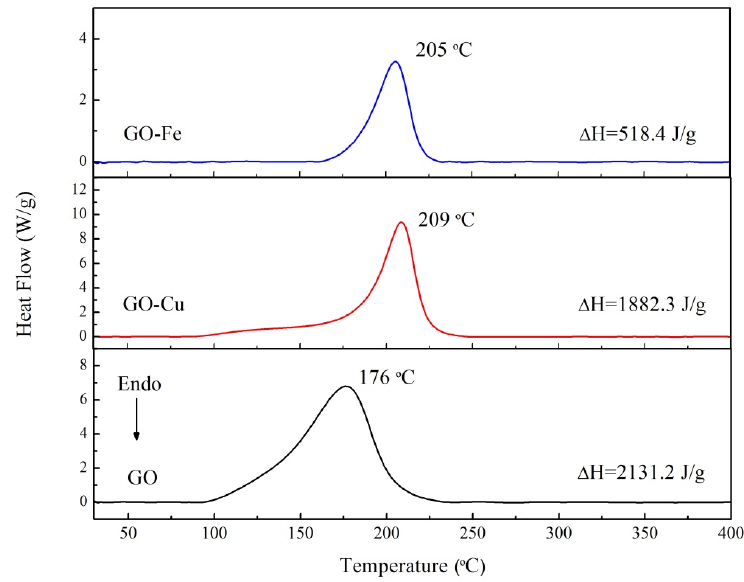
Figure 5. DSC curves of nGO, nGO-Cu, and nGO-Fe with heating rate of 10 °C/min.